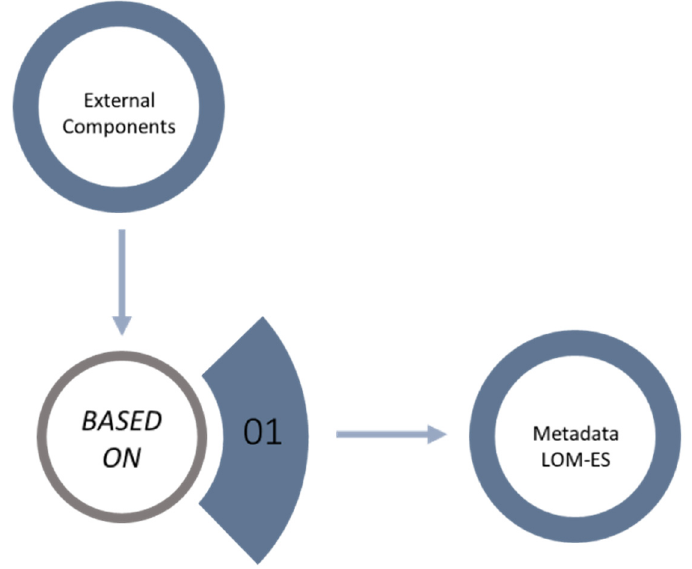
Figure 4. Taxonomy of learning objects. External components. Fuente: Basado en Cuervo (2011); Castrillón (2011); Sánchez Medina (2014).